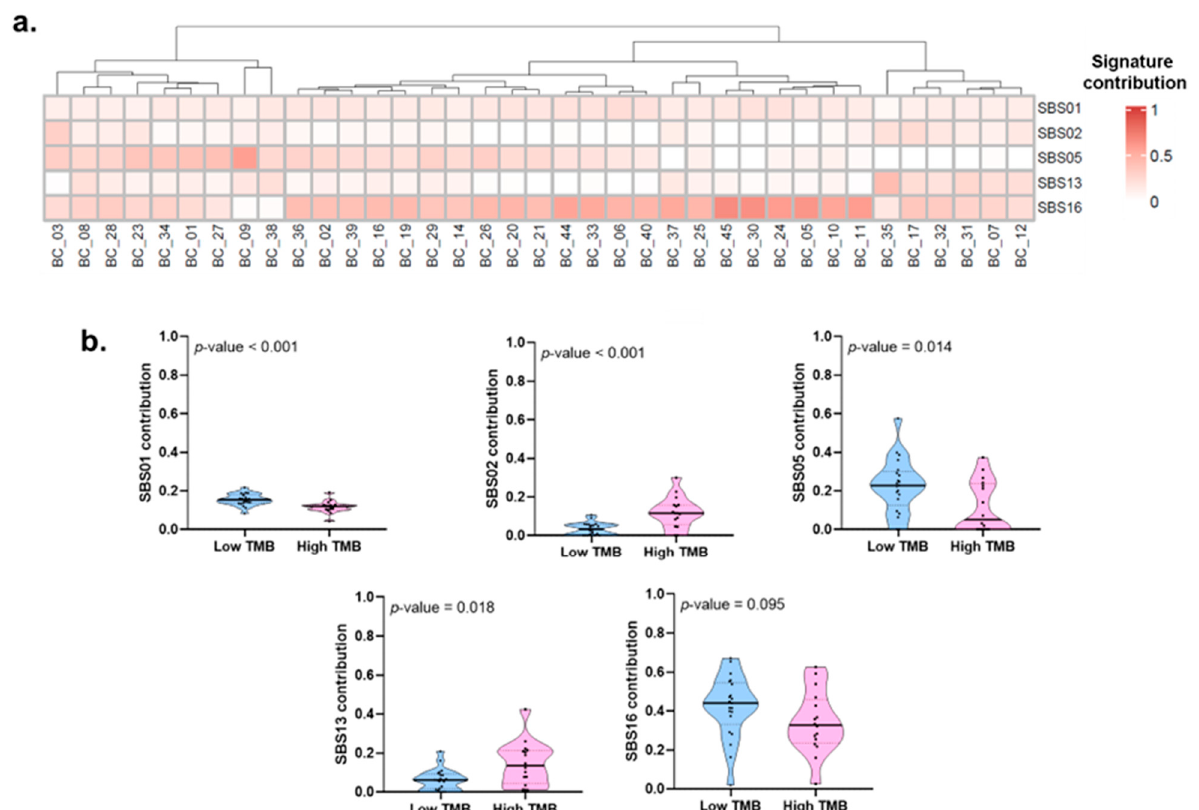
Figure 7. Mutational processes and their association with TMB status of patients with bladder cancer treated at the INCan (N = 37) between 2012 and 2021: ( a ) Heatmap showing the contribution of the mutational signatures to the carcinogenic process. Only single-base substitution signatures (SBS) with a contribution more significant than cero were depicted. The gradient red color indicates the grade of the contribution of each signature; ( b ) Violin plot depicting the association between the tumoral mutational burden (TMB) status of the patients and SBS01, SBS02, SBS05, SBS13, and SBS16. We did not find any association between TMB and clinical features (Supplementary Figure S1).